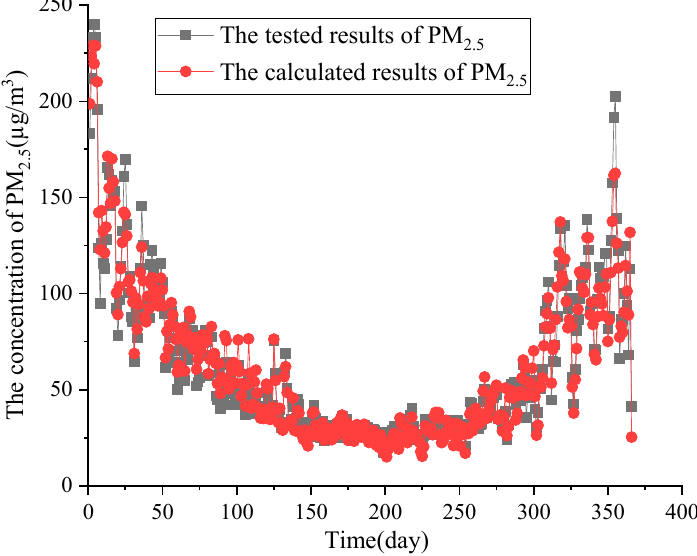
Figure 7. Comparison of calculated results and actual data of PM 2.5 . The results show that the calculated results and actual data of the daily average concentrations of various pollutants from 2016 to 2020 were in good agreement, with the model showing a good prediction effect. However, there was a large fluctuation between PM 2.5 results and data in spring and winter, while the relative consistency between them in summer and autumn was higher. There was a certain deviation in the prediction effect, but overall, it still showed good agreement [23]. Therefore, it was concluded that the daily average concentrations of pollutants in the atmosphere could be effectively predicted and monitored using the multiple linear regression model (Equation (2)). This model is of great significance to understand and analyze the spatio-temporal concentration distribution characteristics and correlations with other pollutants of atmospheric particulate matter as affected by relevant policies employed recently